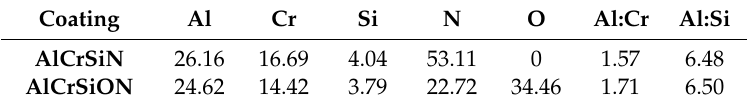
Table 2. Chemical compositions of the AlCrSiN coating and AlCrSiON coating